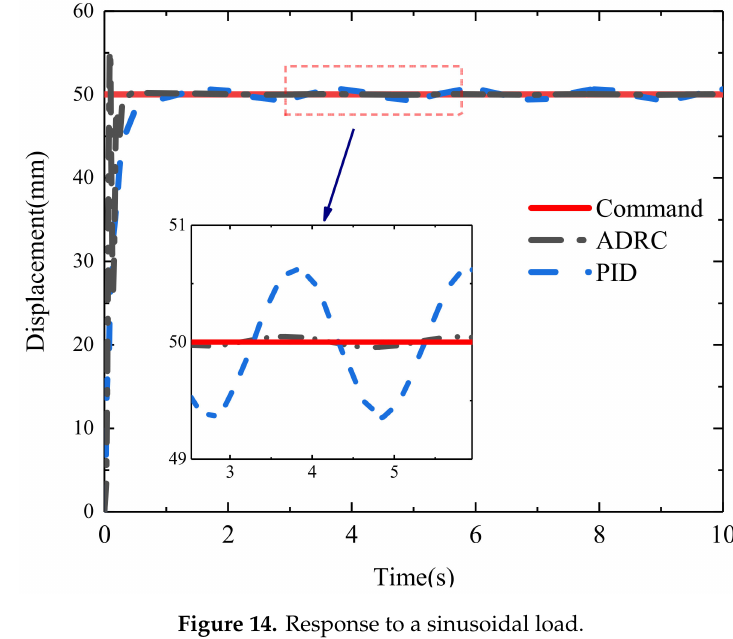
Figure 14. Response to a sinusoidal load.